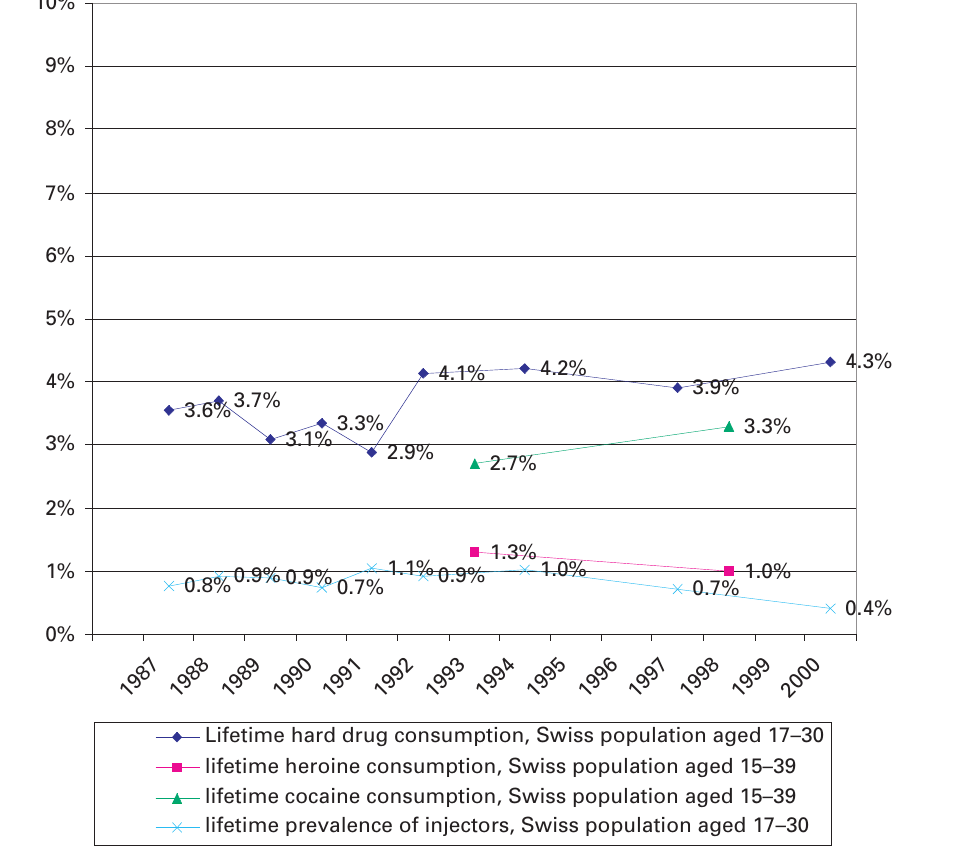
Figure 1 Evolution of heroine and/or cocaine life- time consumption among the Swiss population (1987–2000)